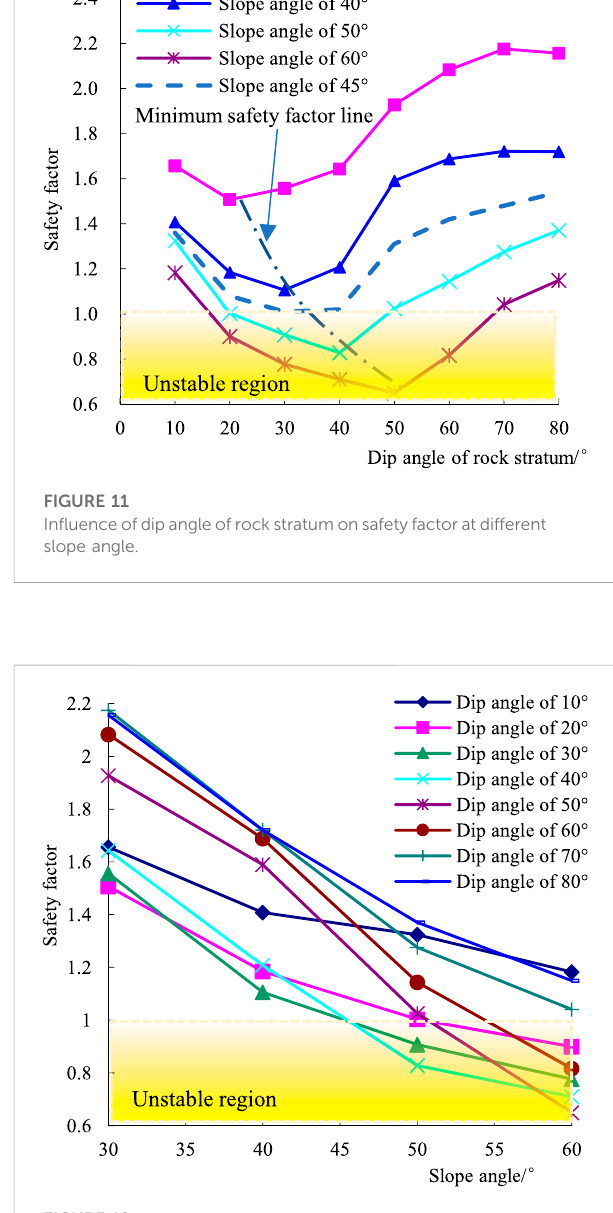
FIGURE 12 In fl uence of slope angle on safety factor at different dip angle of rock